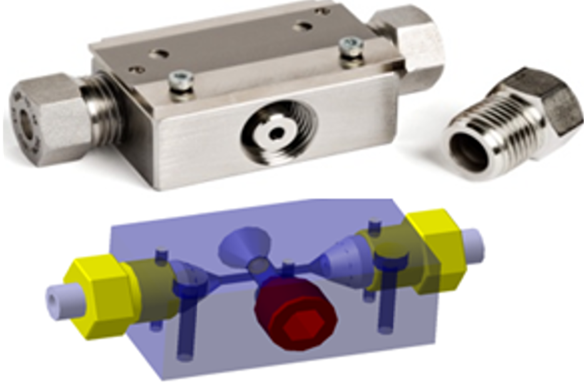
Figure 9: Picture and scheme a laboratory-SAXS gas cell used for gas sorption measurements of coal. X-rays enter from the detach- able entrance-window (front). On the right and left sides the high- pressure tubes for the compressed gas are connected